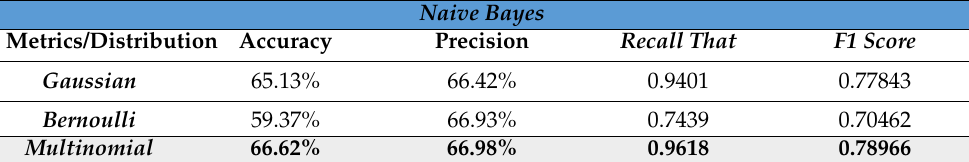
Table 6. Benchmark for Naive Bayes.